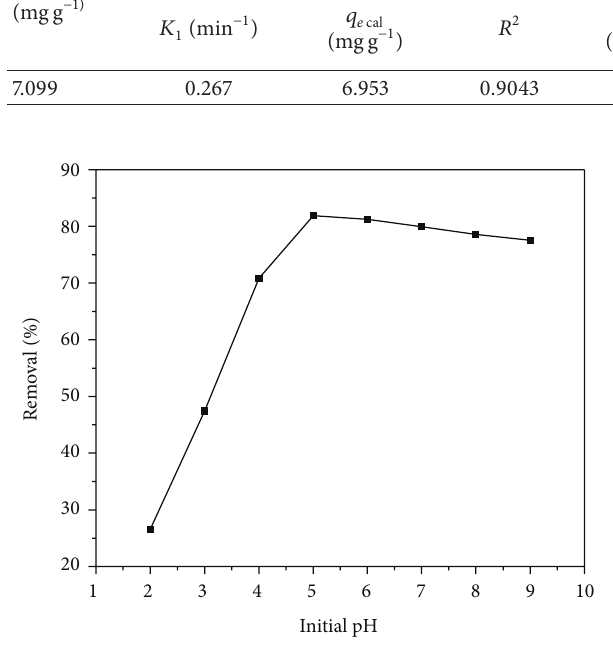
Figure 5: Pseudosecond-order kinetic model for Cd(II) onto